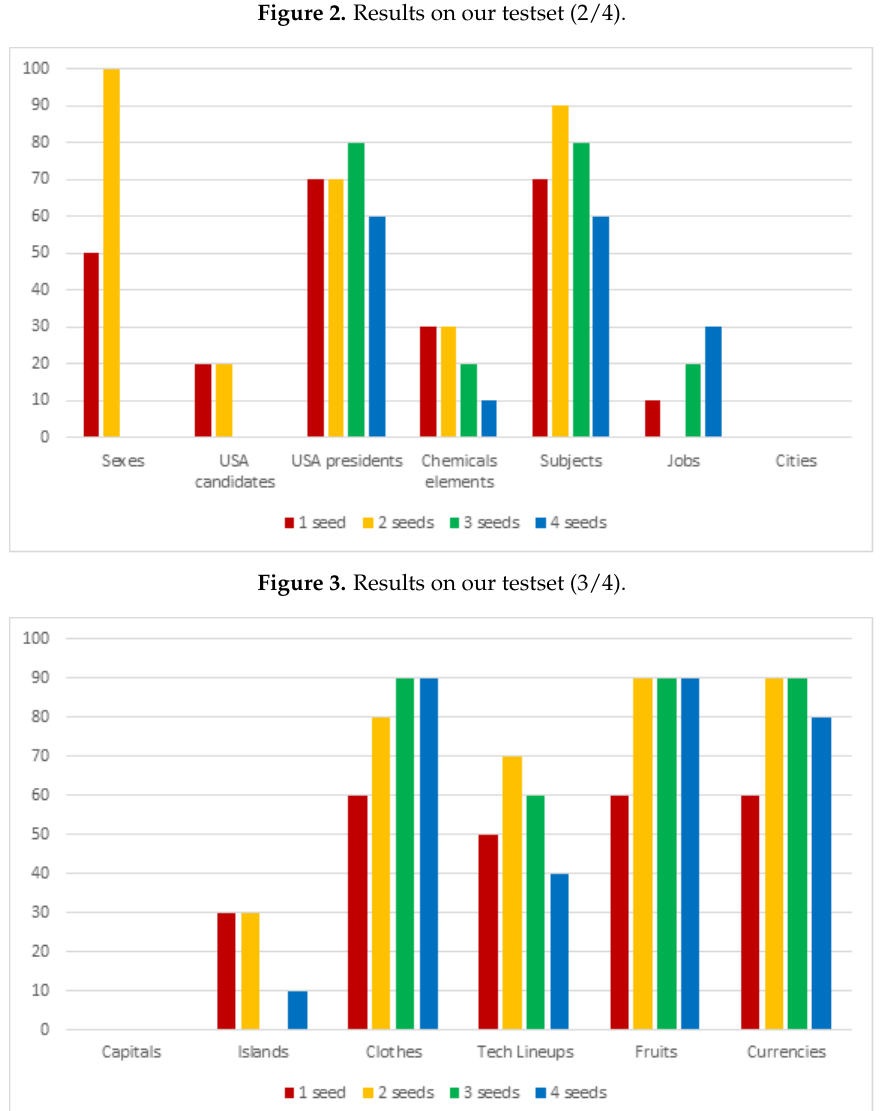
Figure 4. Results on our testset